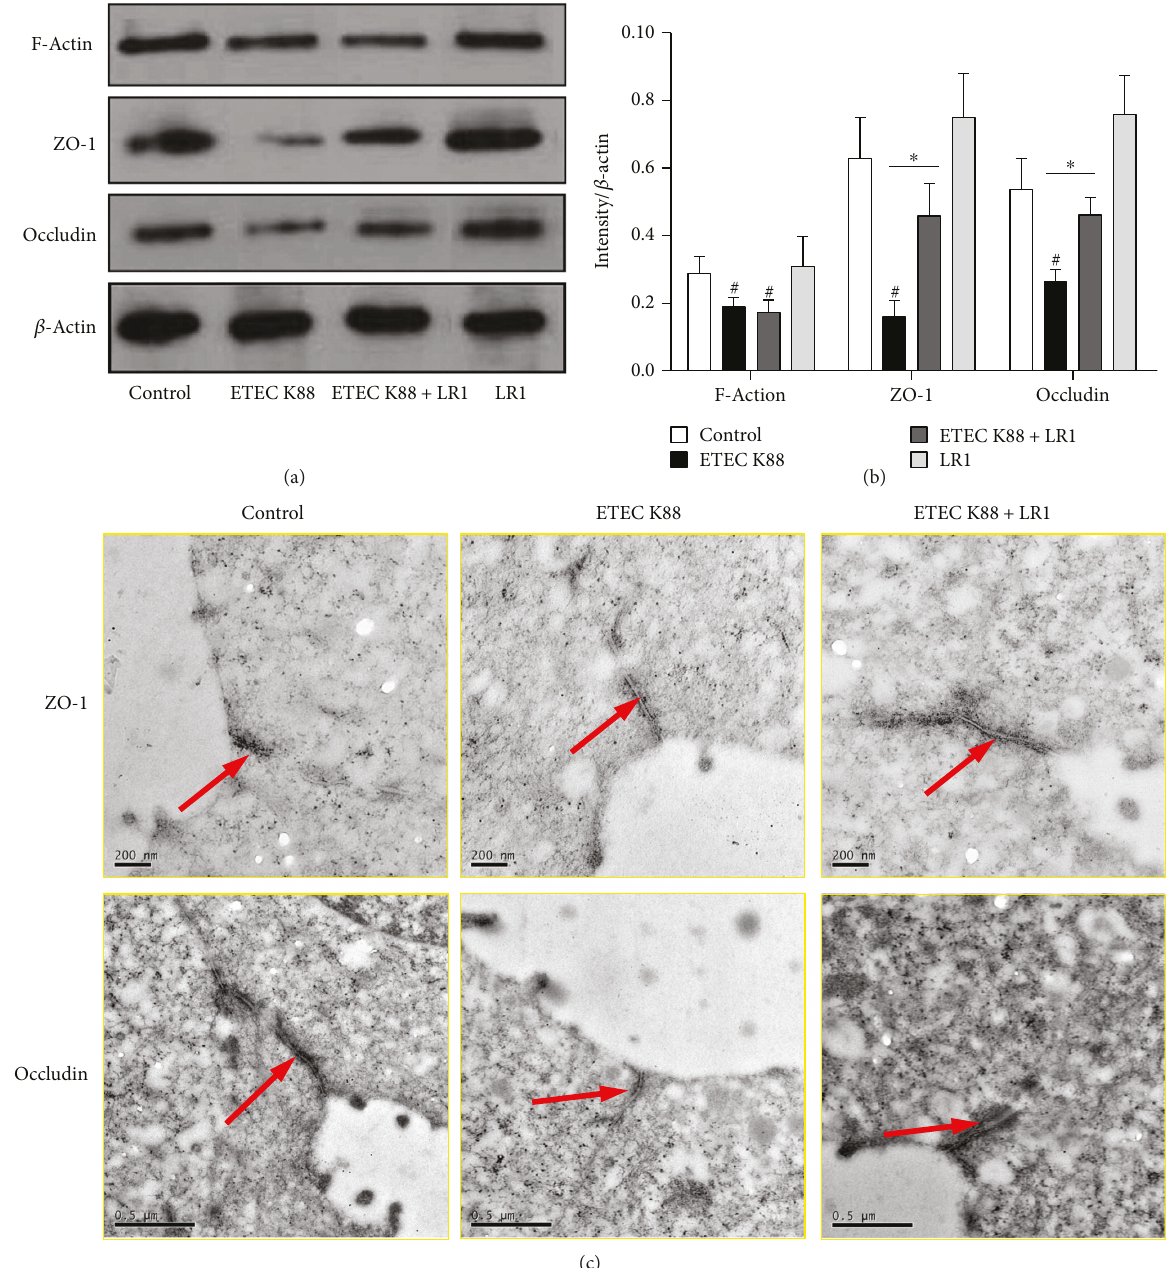
Figure 3: The contents of TJ proteins in IPEC-1 cells . (a) The contents of ZO-1, occludin, and F-actin in IPEC-1 cells were determined by Western blot analysis. (b) The relative intensity of target proteins to β -actin was calculated. All data are expressed as the mean ± SEM ( n = 3 ) and representative of 3 independent experiments. Di ff erences were determined by one-way ANOVA. # P < 0 05 compared with control, ∗ P < 0 05 . (c) ZO-1 and occludin in IPEC-1 cells visualized by colloidal gold immunoelectron